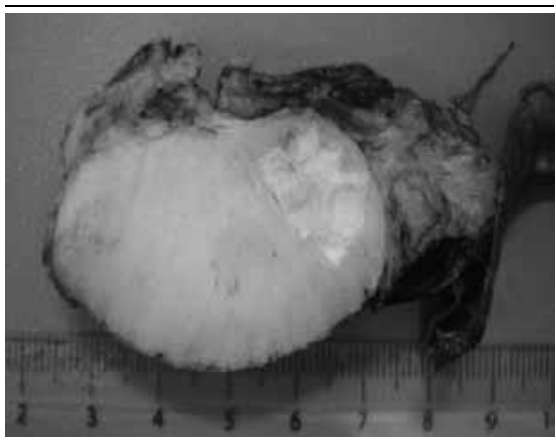
figurE 1 – Macrophotograph of testis section displaying polar cyst with pasty and whitish content